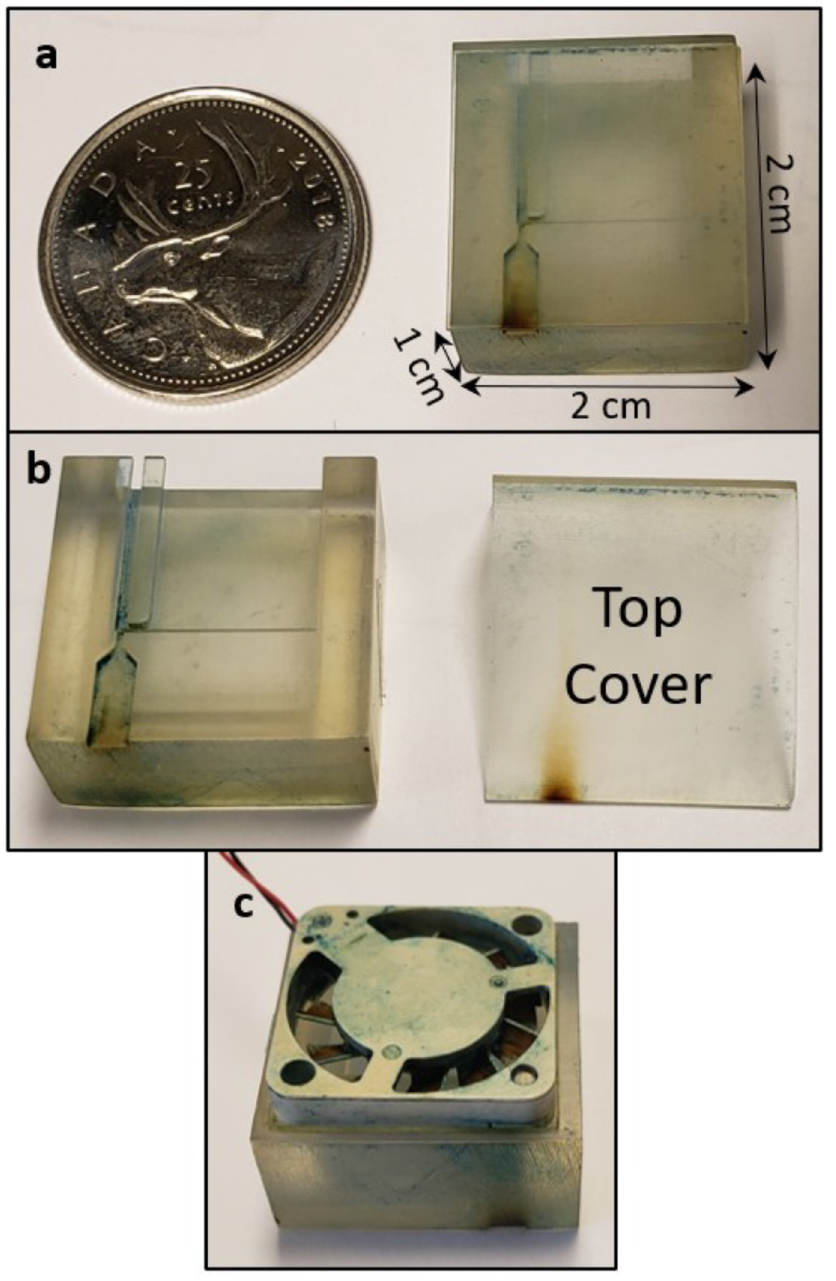
Figure 8. ( a ) Dimensions of the 3D-fabricated virtual impactor with the top cover, compared to a Canadian 25 cent coin. ( b ) Virtual impactor, with the top cover removed. ( c ) Fan at the outlet of the virtual impactor.